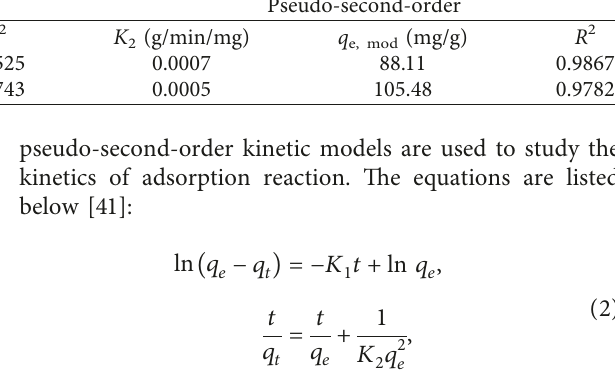
Table 1: Kinetic parameters for the removal of Cr (VI) on TGOM. Pseudo-first-order